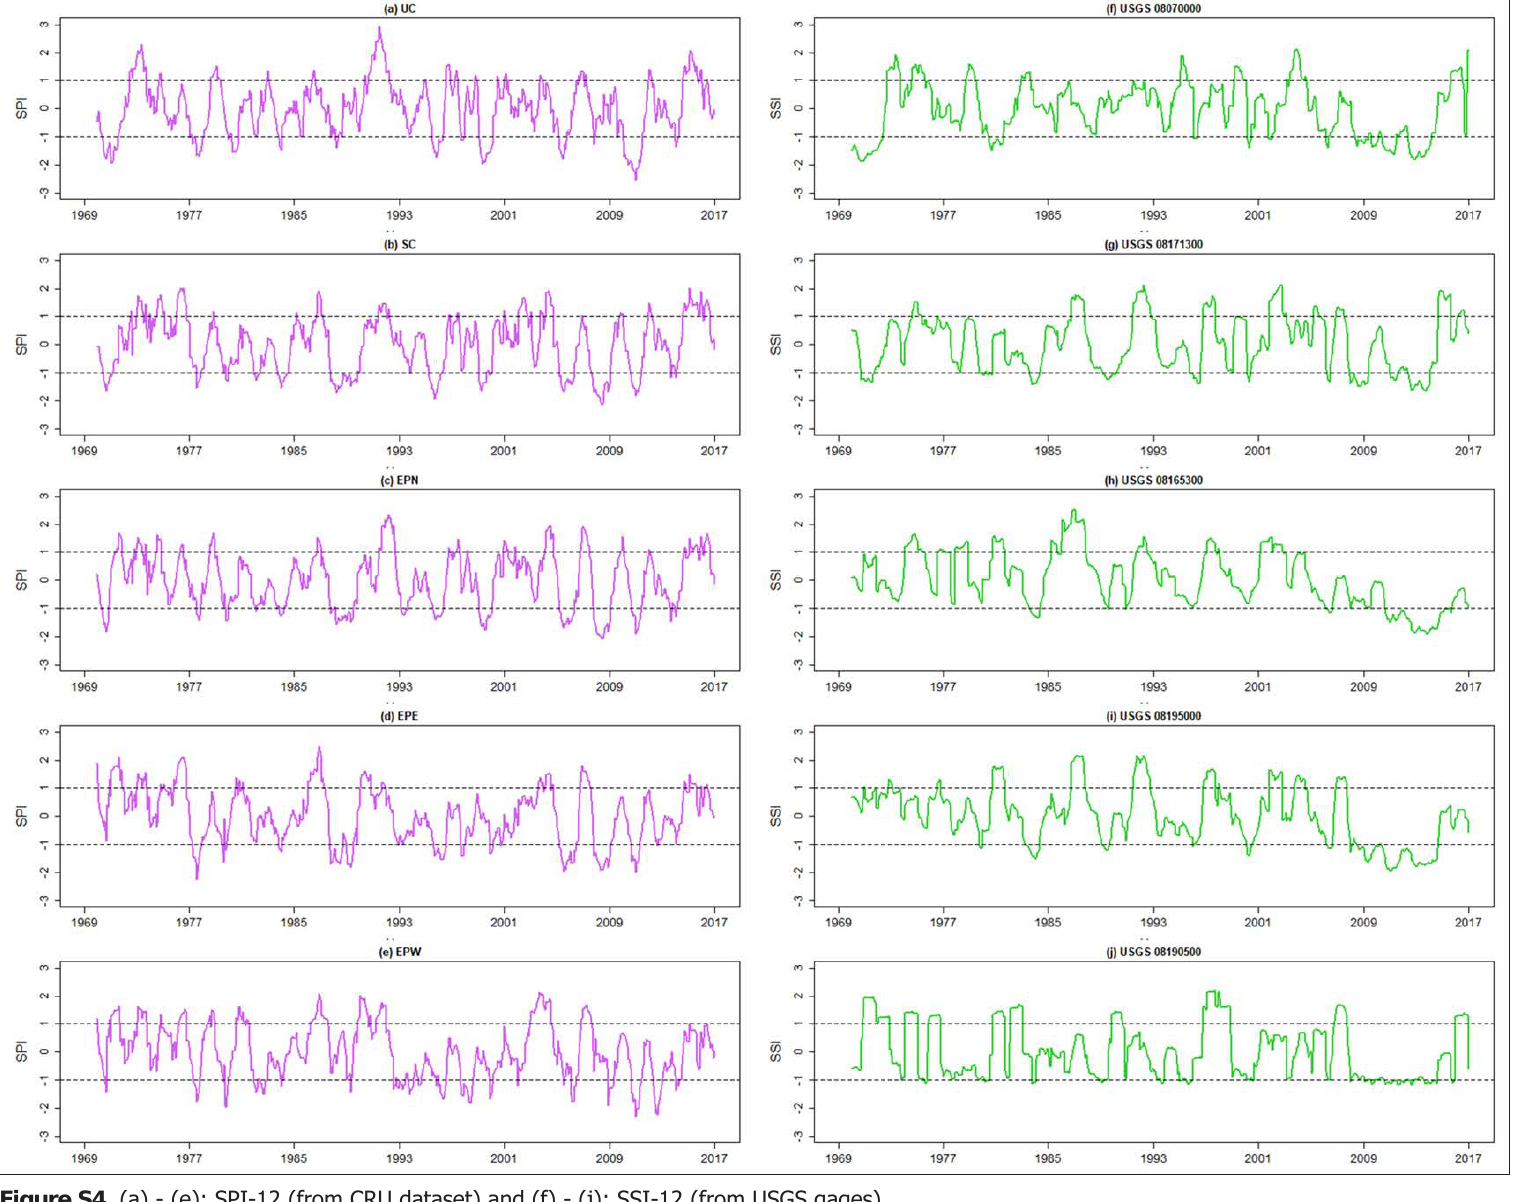
Texas Water Journal, Volume 14, Number